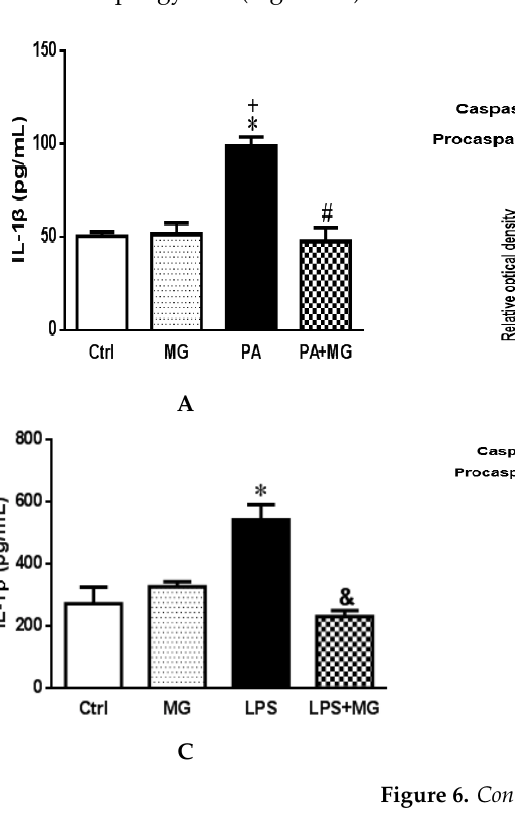
Figure 5. Effects of magnolol (MG) treatment on lipid homeostasis in steatotic HepG2 cells. ( A ) Representative Western blot and densitometry analysis of SREBP-1c and FAS; ( B ) relative mRNA expression of lipogenesis markers Srebp-1 , Fas , Acc , Scd , and Cd36; ( C ) representative Western blot and densitometry analysis of HSL and ATGL; ( D ) relative mRNA expression of lipolysis markers Hsl , Mgl , and Atgl . Data are expressed as mean ± SEM, n = 4. * p < 0.05 vs. Ctrl; # p < 0.05 vs. PA (palmitic acid).